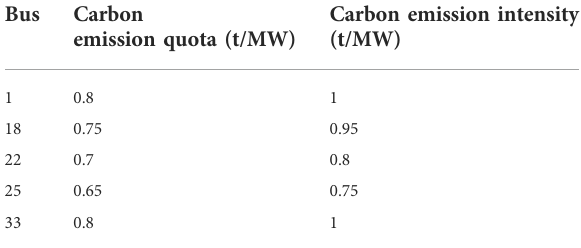
TABLE 3 The carbon emission factors of carbon emission